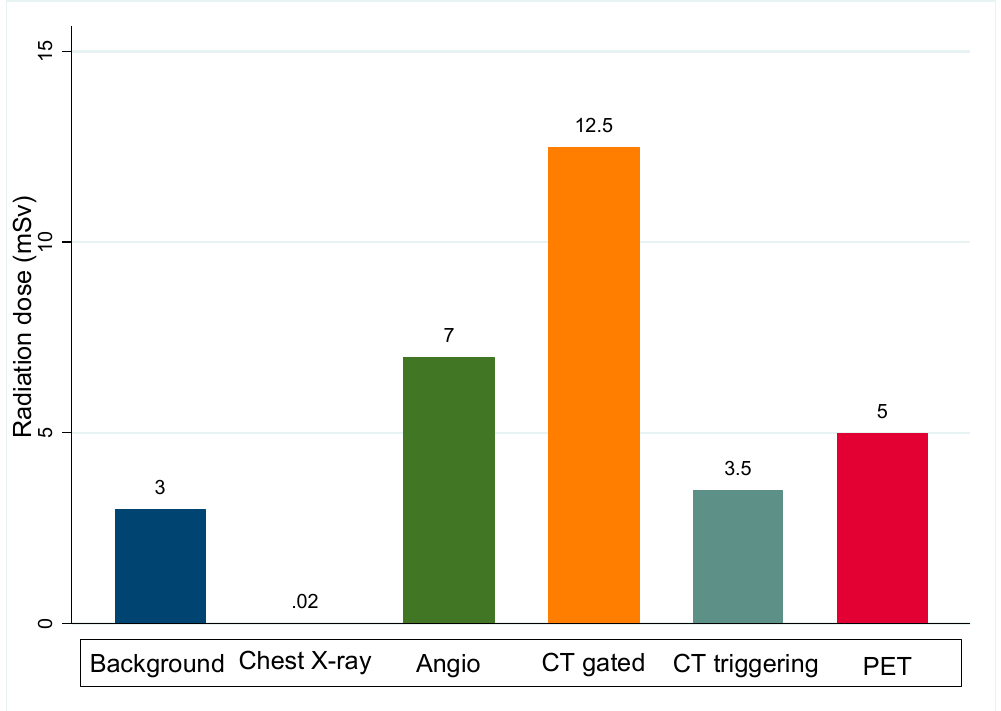
Figure 7. Radiation dose of coronary atherosclerosis imaging modalities, compared to natural annual background radiation dose. CT gated: Retrospective ECG-gated CT scan. CT triggering: Prospective ECG-triggering CT scan. PET: positron emission tomography.